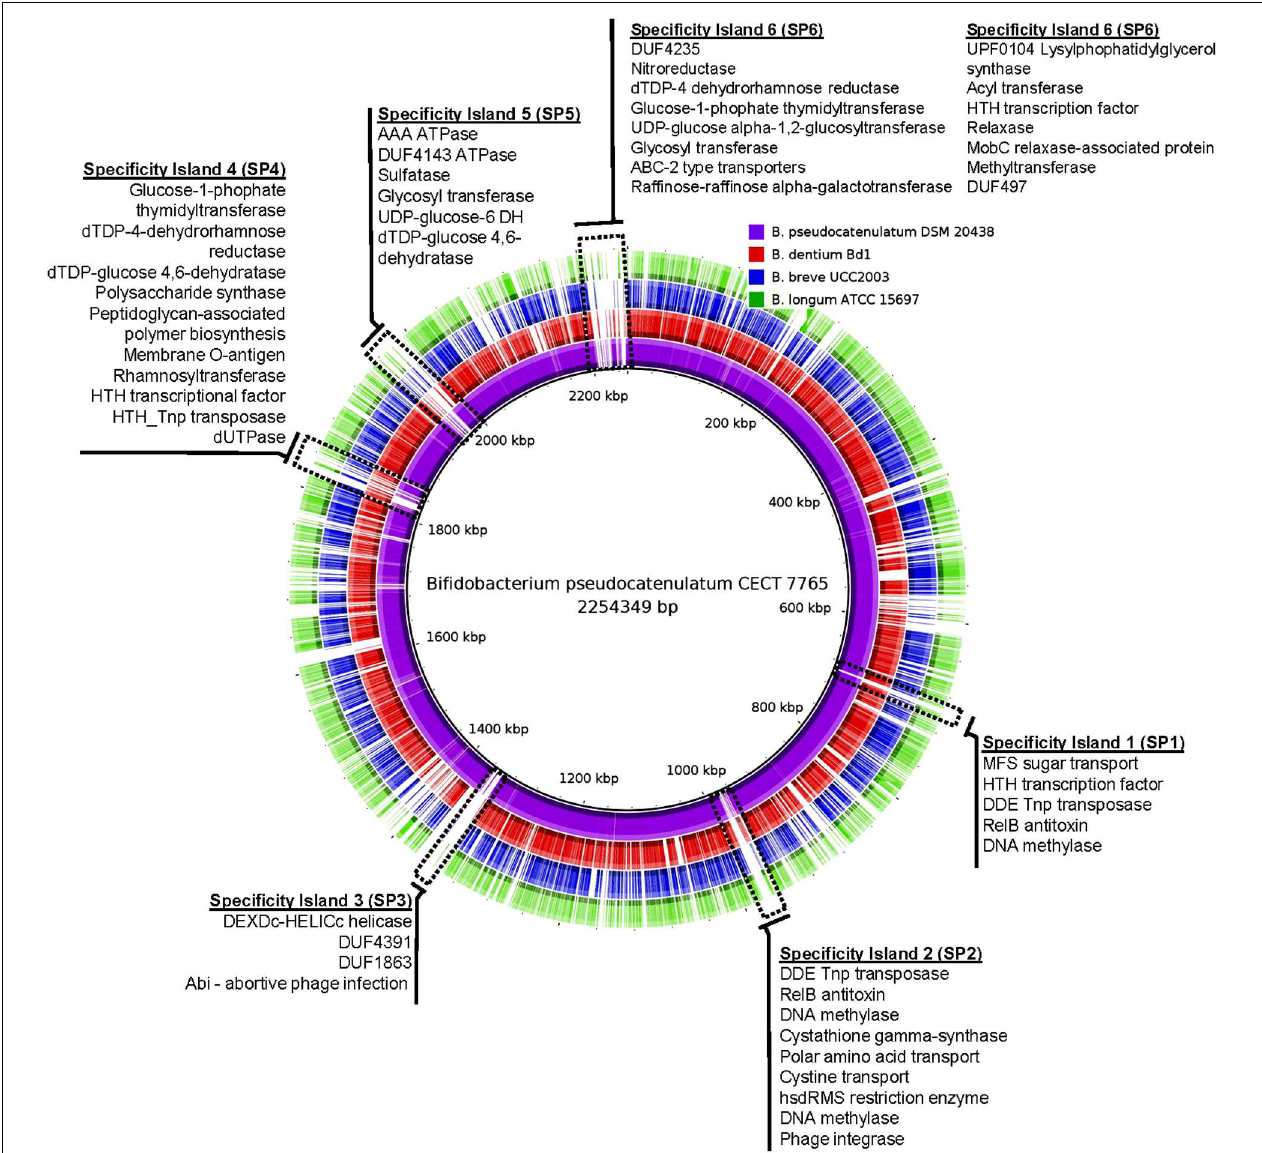
FIGURE 1 | Comparative analysis of Bifidobacterium pseudocatenulatum CECT 7765 and close species. Circular representation of B. pseudocatenulatum CECT 7765 (black inner line), B. pseudocatenulatum DSM 20438 (purple), B. dentium Bd1 (red), B. breve UCC2003 (blue), and B. longum subsp infantis ATCC 15697 (green) genomes. They are compared using whole-genome and blast-based alignment. Genomic regions exclusively found on B. pseudocatenulatum CECT 7765 are highlighted with dashed rectangles with functional annotation of genes present alongside,